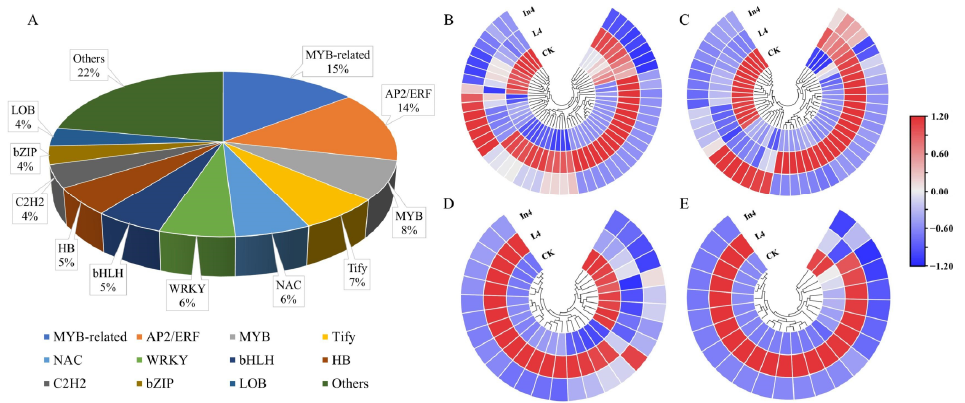
Figure 8. Changes in relative expression levels of DEGs encoding transcription factors in P. koraiensis under different supplementary lights. ( A ) The percentage of transcription factor families in all comparison groups. Heatmaps of DEGs involved in ( B ) MYB-related, ( C ) AP2/ERF, ( D ) MYB, and ( E )